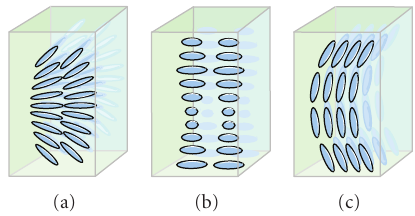
Figure 3: (a) The splay, (b) twist, and (c) bend deformation.